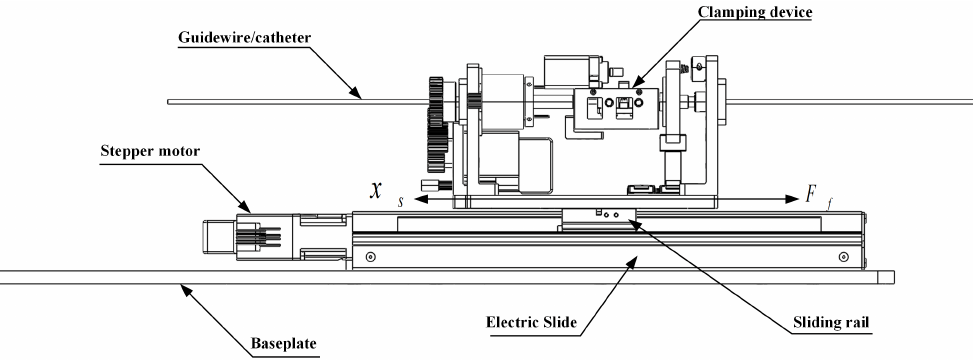
Figure 7. Dynamic model of the propulsion